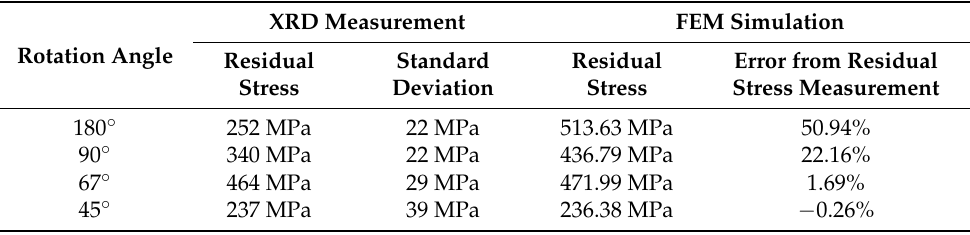
Table 3. Residual stress